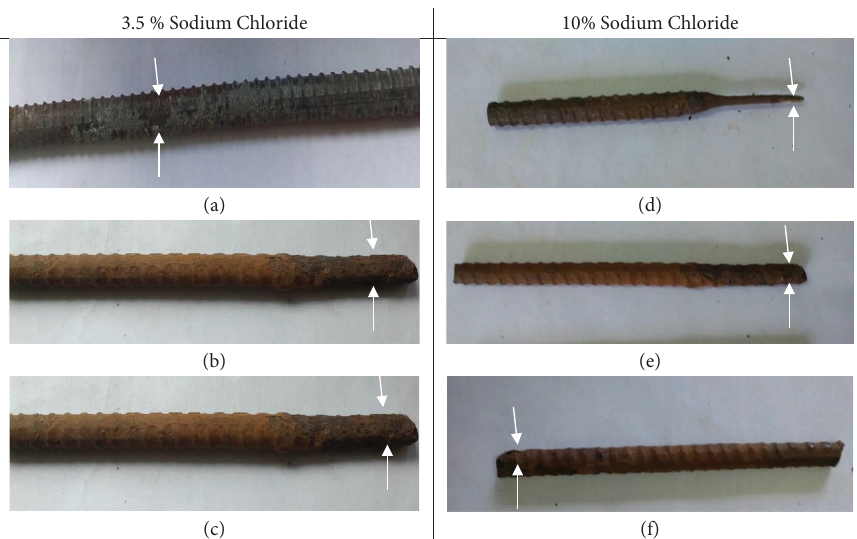
Figure 9: Corroded rebars after 6V accelerated current. (a) Uncoated rebar (7.06 cm), (b) zinc-coated rebar (9.5cm), (c) nano PCB-coated rebar (9.56 cm), (d) uncoated rebar (1.6cm), (e) zinc-coated rebar (8.64cm), and (f) nano PCB-coated rebar (8.75